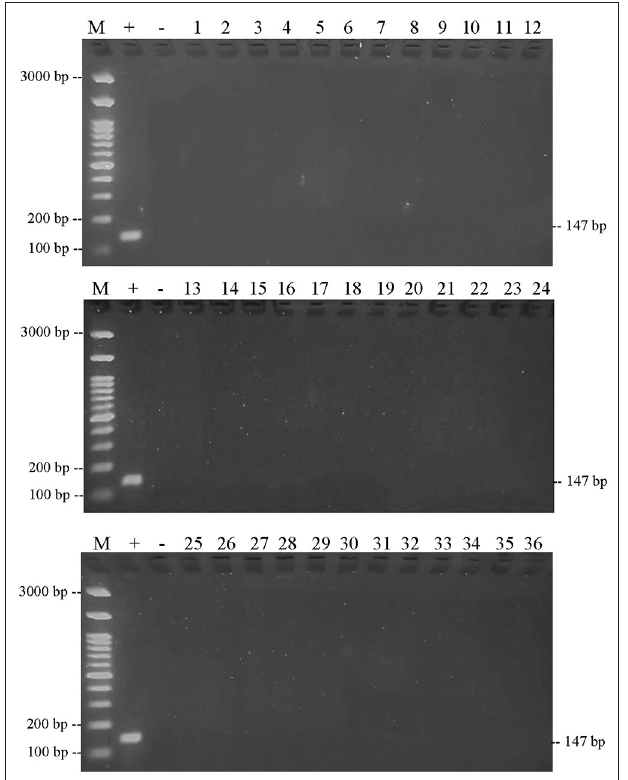
FIGURE 7 | Results of PCR amplification of meatball samples in Bojonegoro Regency with pork primers electrophoresed on a 2% agarose gel. (M) DNA marker 100 bp; ( + ) positive control meatballs; (–) negative control (no template control); samples were coded with numbers N1–N36.